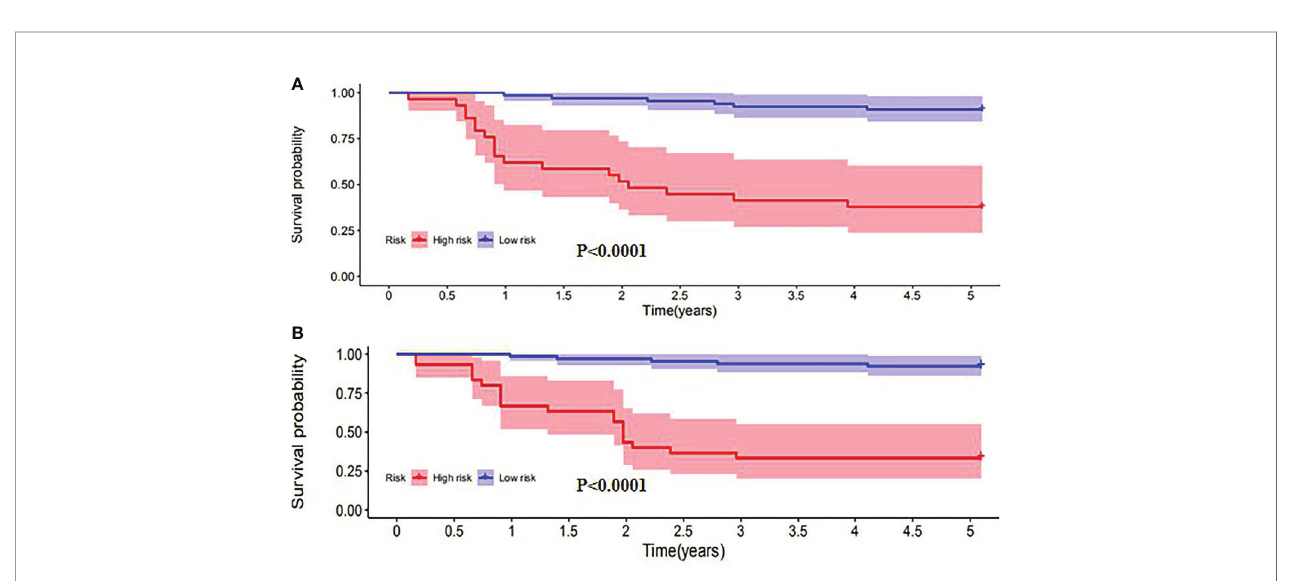
FIGURE 6 | Kaplan-Meier analysis of PFS for patients strati fi ed by the risk strati fi cation system in the original model (A) and validation model (B)